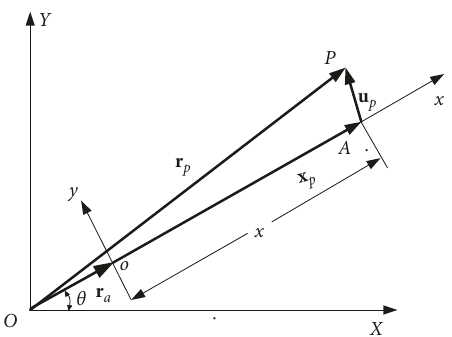
Figure 2: Displacement field at any point on the beam